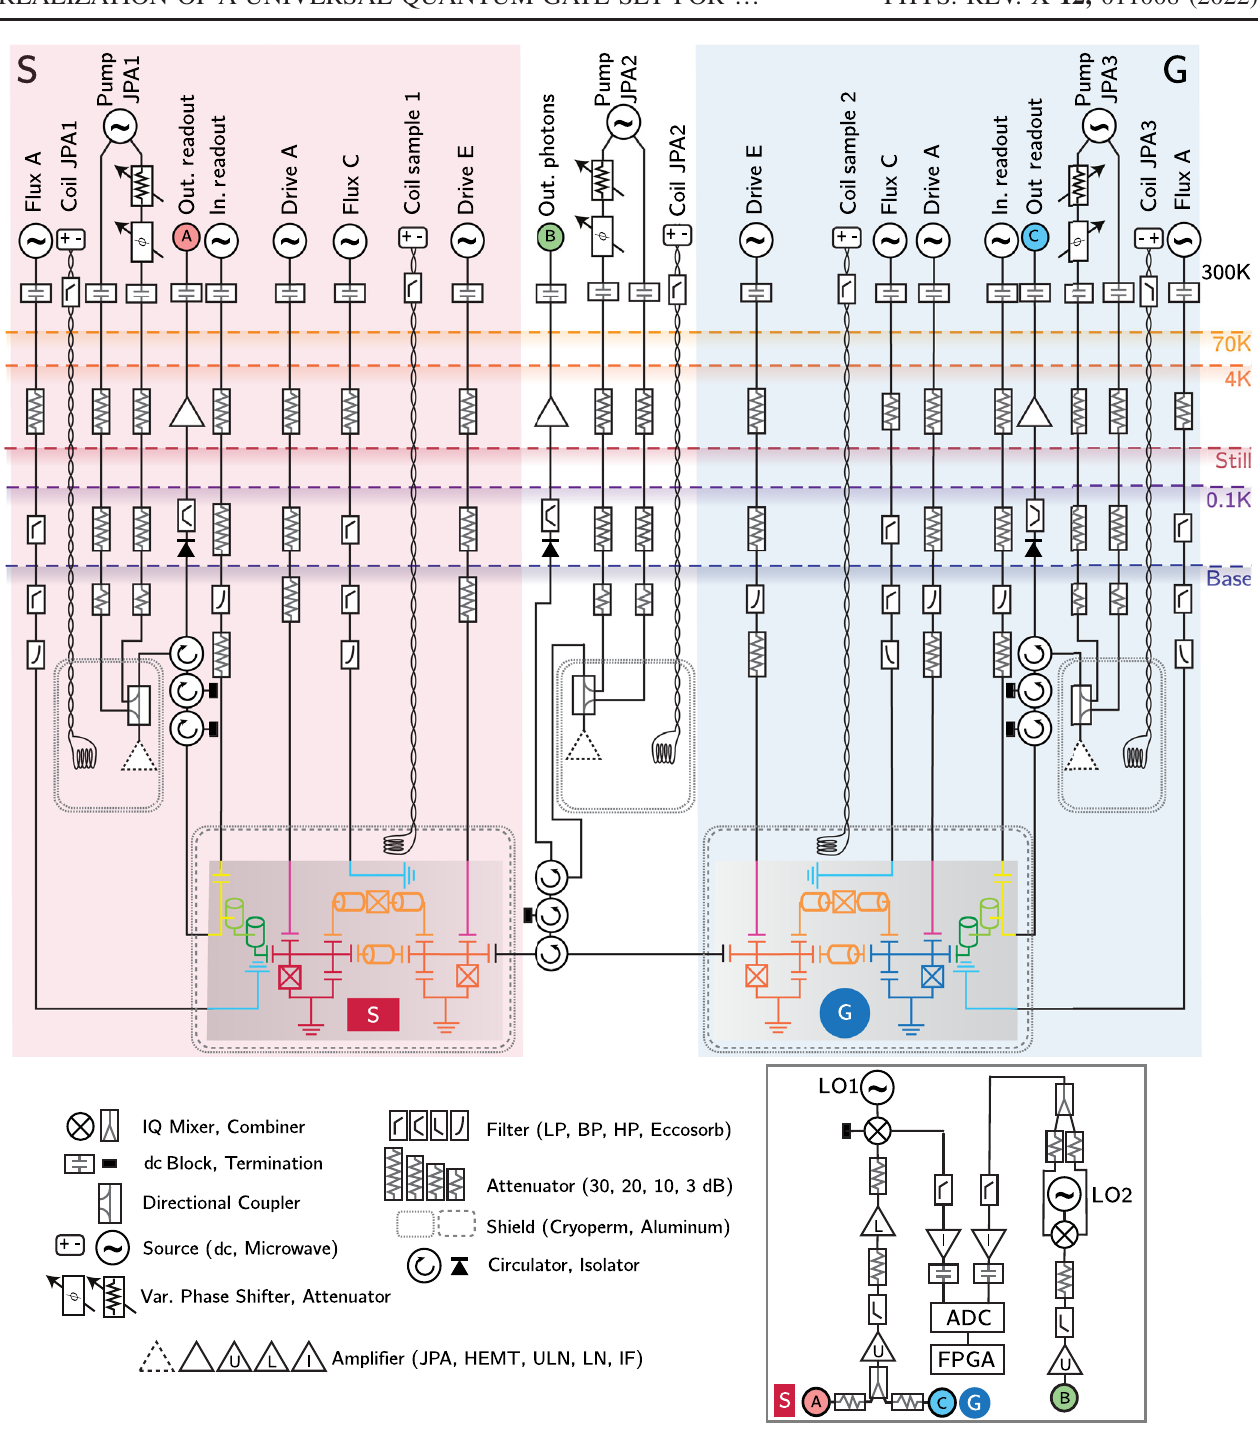
FIG. 6. Experimental setup for operating the source qubit ( S , red) and the gate qubit ( G , blue) devices. For details, see the